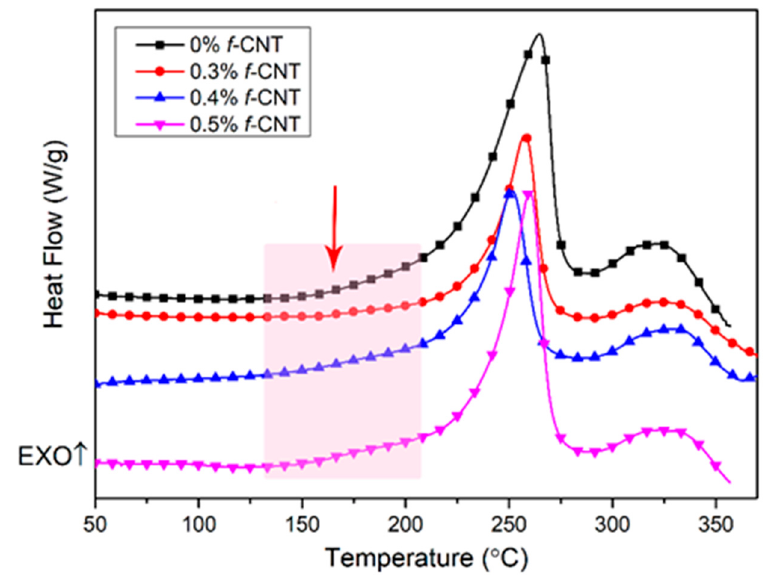
Figure 3. Curing behavior of h-BN/ f -CNTs reinforced matrix blends.